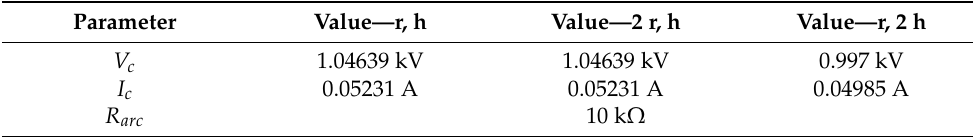
Table 8. Advanced Capacitive Model’s